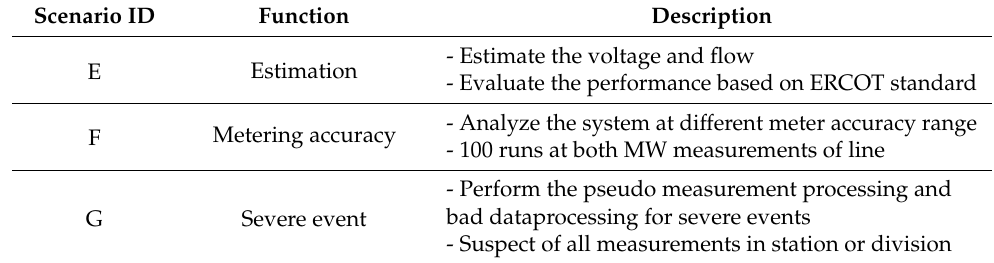
Table 12. Scenario of a dynamic test on KEPS.